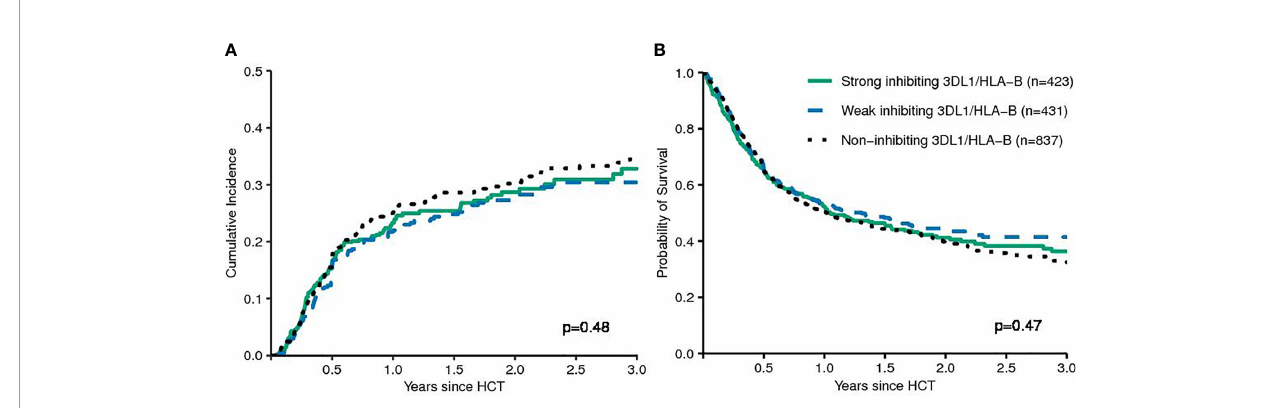
FIGURE 1 | Patients were grouped by their donors ’ KIR3DL1/HLA-B subtype combinations (strong inhibiting versus non-inhibiting/weak inhibiting) in terms of relapse incidence (A) and event-free survival (B) . The p-values have been calculated by the Gray Test (CIR) and the log-rank test (EFS).